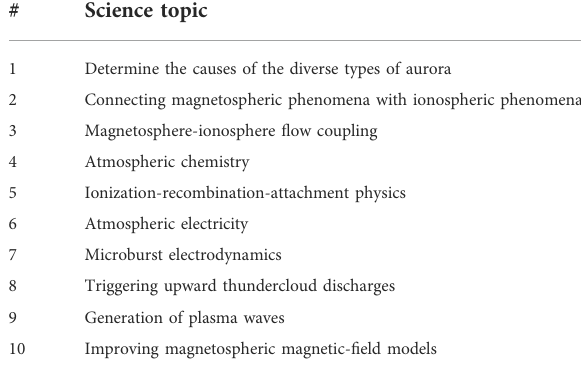
TABLE 1 Summary of the science of MIOfor the diverse Earth-system- science communities:seealso Sanchez etal.,2019,Marshallet al., 2019, and Borovsky et al., 2020c and in particular the Appendix of Borovsky et al., 2020b for details and references.